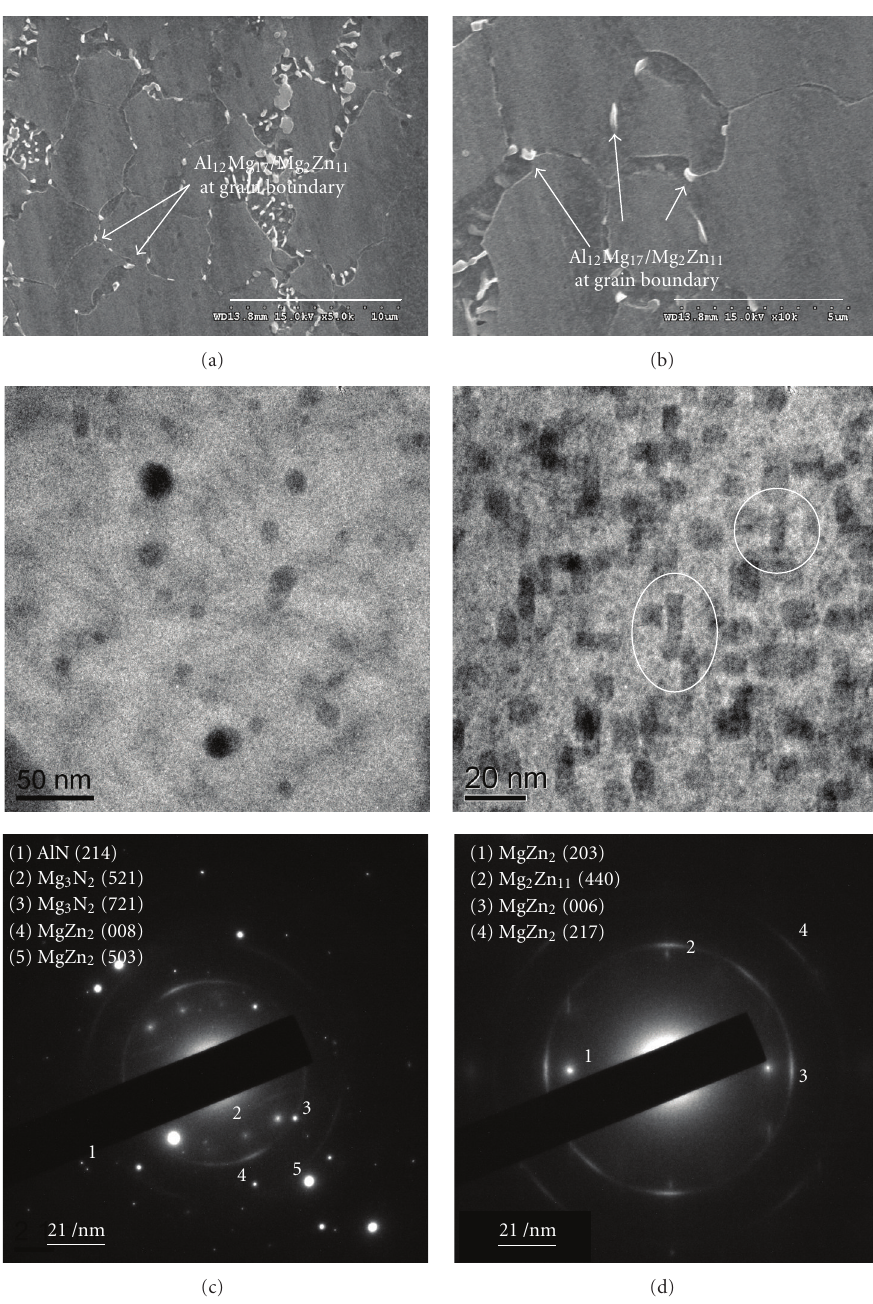
Figure 2: Representative FESEM micrographs showing grain size in monolithic AZ91/ZK60A and AZ91/ZK60A/AlN nanocomposite: (a) lower magnification and (b) higher magnification. (c) Representative TEM micrograph (including SAED pattern) showing the presence of individual nitride nanoparticles and fine intermetallic particles in AZ91/ZK60A/AlN nanocomposite. (d) Representative TEM micrograph (including SAED pattern) showing the presence of individual Mg-Zn rod-shaped nanoparticles in AZ91/ZK60A/AlN nanocomposite. Phases present but not labeled in the SAED patterns include Mg and Mg-Al phases